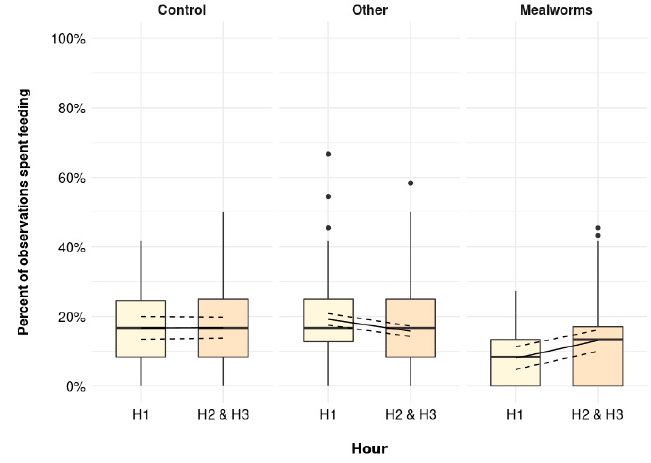
Figure 5. The percentage of observations spent feeding at the feeder immediately after scattering was provided (H1) and later in the day (H2 and H3) for Control (no scattering), Other (scattering of shavings, whole wheat, alfalfa, or cabbage), and Mealworms ( p = 0.001). Boxplots show medians, lower, and upper interquartile range of raw data. Whiskers indicate 1.5 times the interquartile range. Solid lines represent estimated means and dashed lines represent 95% confidence intervals.